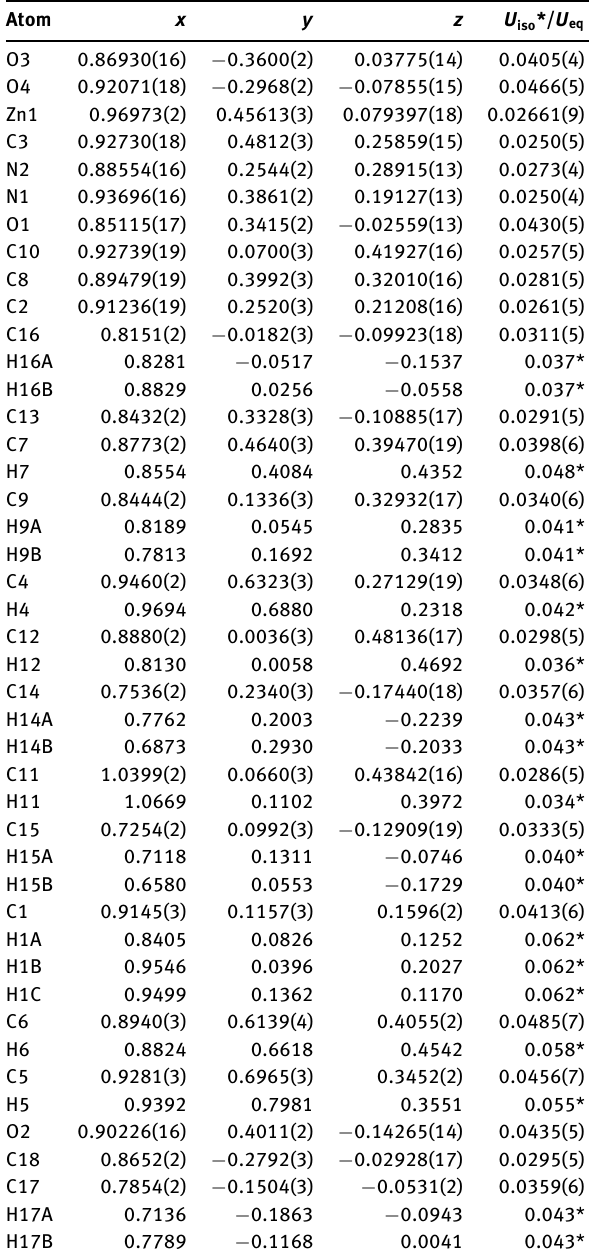
Table 2: Fractional atomic coordinates and isotropic or equivalent isotropic displacement parameters (Å 2 ).